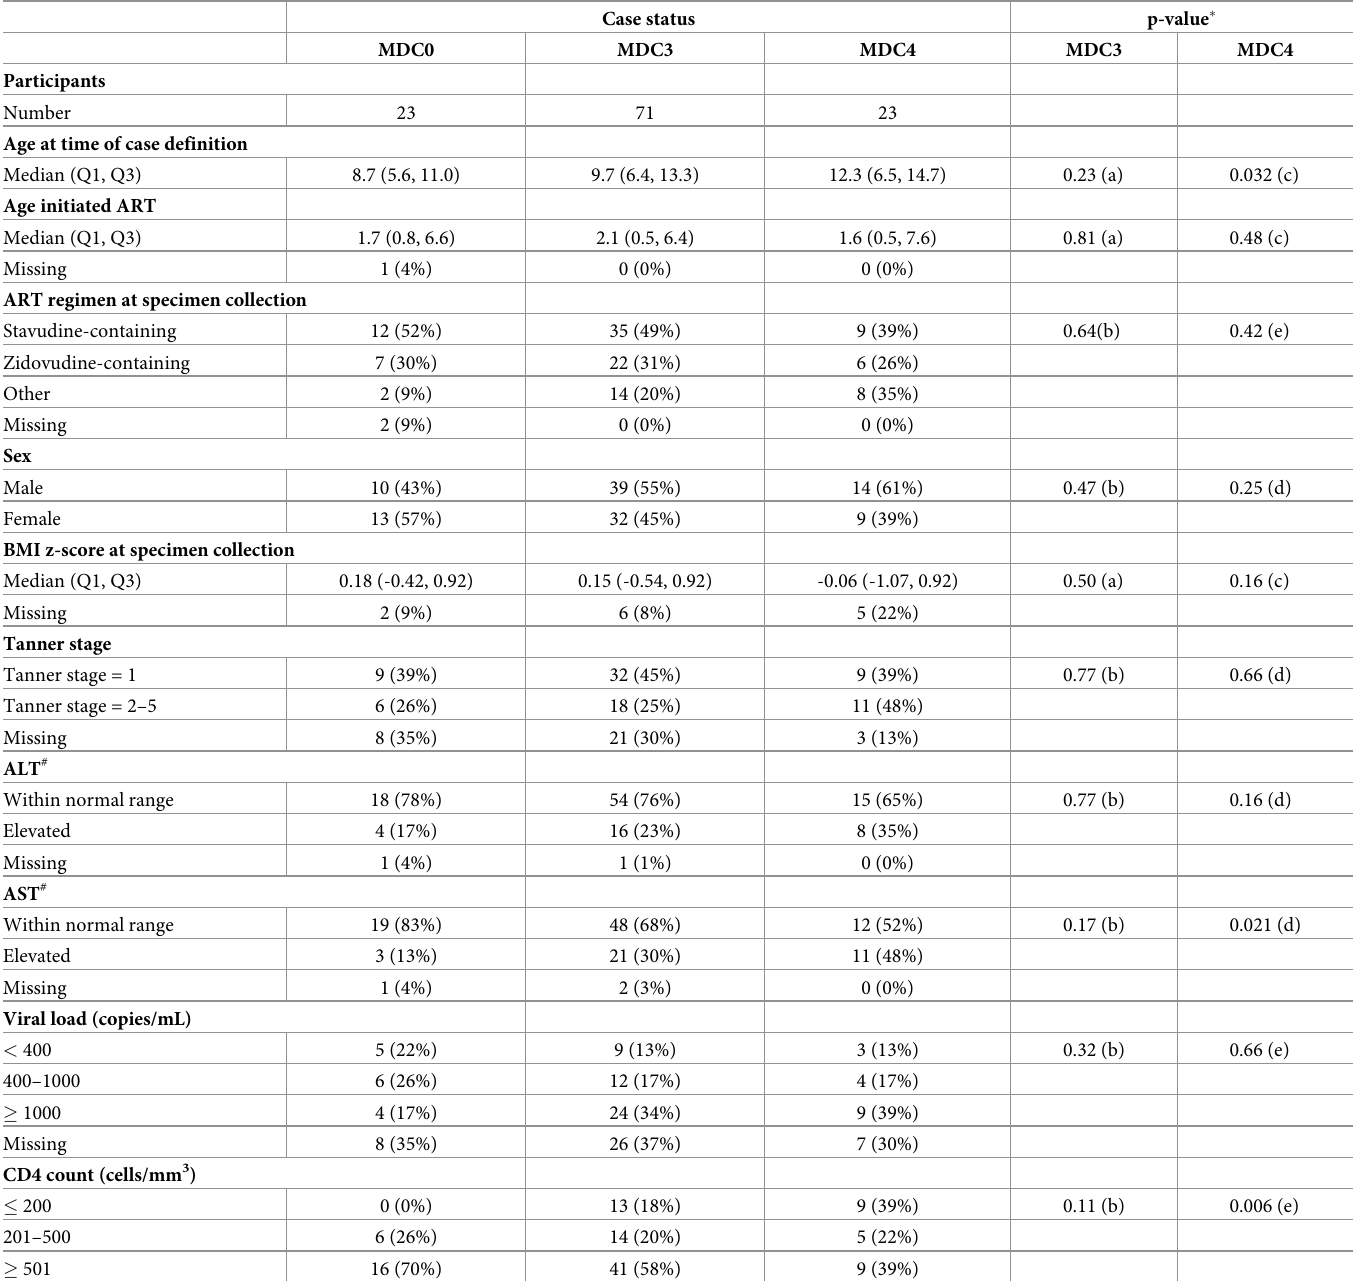
Table 1. Association of clinical characteristics with MDC case